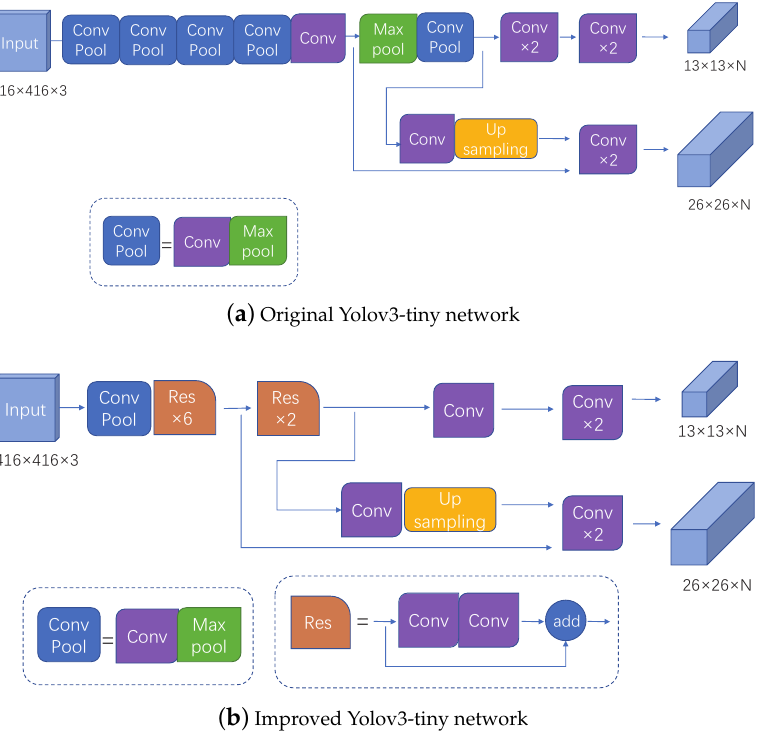
Figure 4. A Yolov3-based dynamic sign language detection